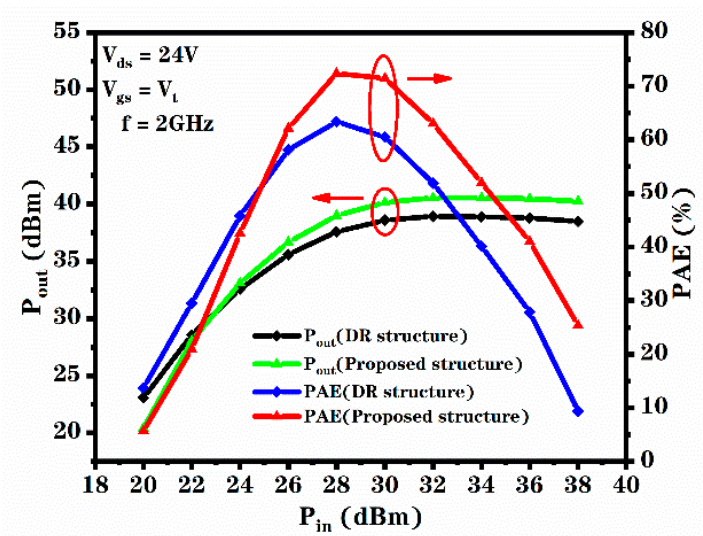
Figure 10. Relationship between PAE and P in for the DR structure and proposed structure.